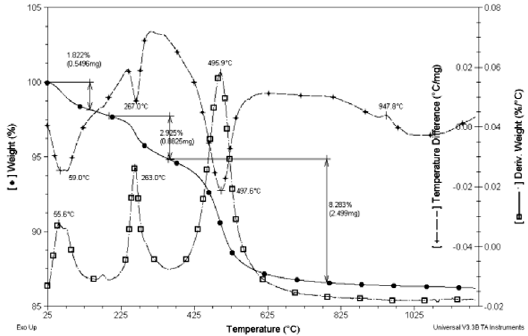
Figure 4. Thermal analysis curves (DTA/TG/DTG) of the natural silty clay.